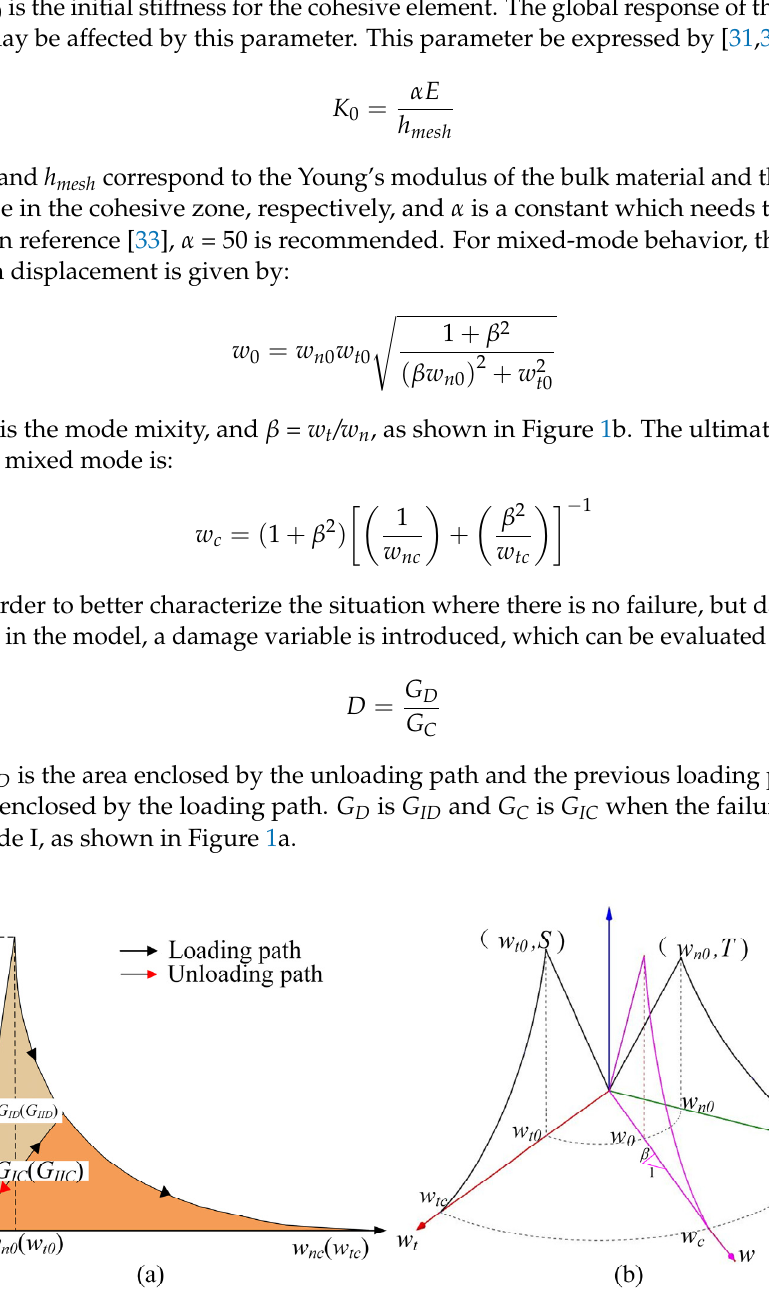
Figure 1. A novel cohesive constitutive model: ( a ) in the pure mode; ( b ) in a mixed model.